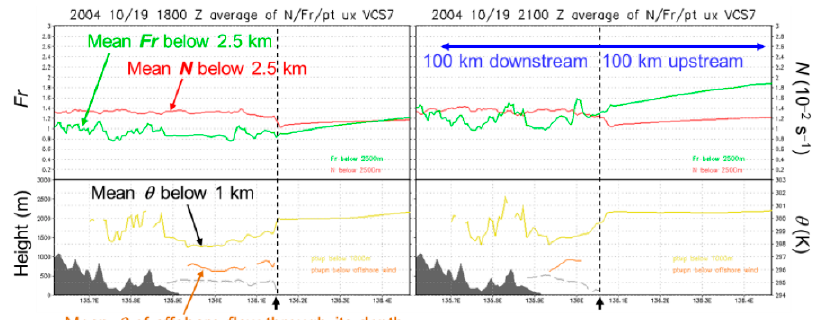
Figure 12. Depth-averaged Fr (solid, scale on left) and N (10 − 2 s − 1 , dashed, scale on right) below 2.5 km (upper panels), and depth-averaged θ below 1 km (K, solid, scale on right), mean θ of offshore flow through its depth (K, dashed), and onshore/offshore flow boundary (gray dashed, height scale on left) along VCS7 for ( a ) 1800 and ( b ) 2100 UTC on 19 October 2004. The terrain is masked in black, and gaps along the curves denote inadequate data levels for calculation.